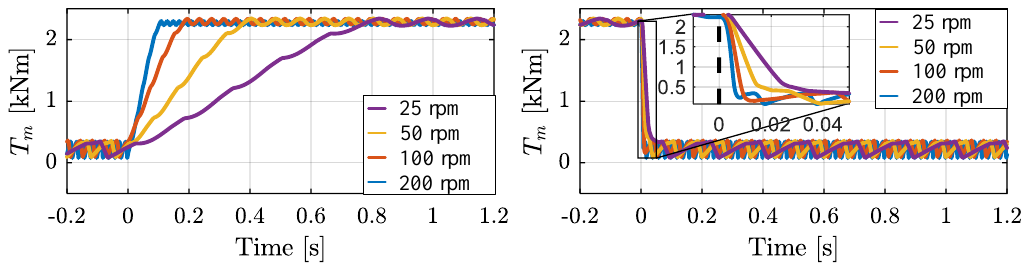
Figure 21. Step-up response ( left plot ) and step-down response ( right plot ) using PSDS Version 1 in the time domain operating at various speeds.